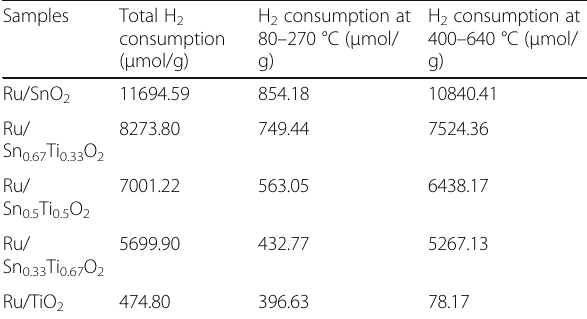
Table 3 Hydrogen consumption of Ru/Sn x Ti 1 − x O 2 catalysts Samples